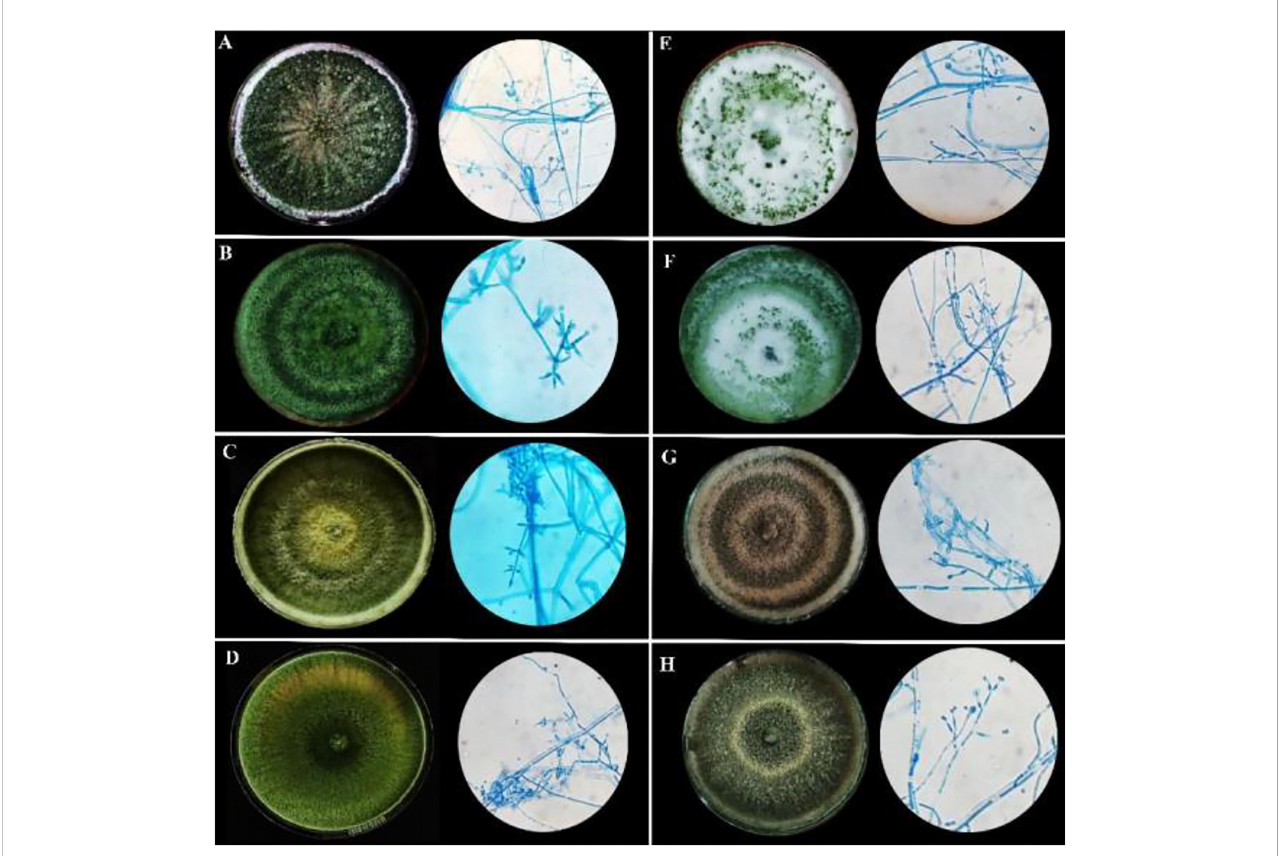
FIGURE 1 Morphological characteristics of rhizospheric fungal colonies on PDA media after sporulation with a detailed study of conidiophore, conidia, and phialides under 40X light microscope. (A) MC2 (B) NBG (C) NBY (D) MCG (E) JC1 (F) JC3 (G) NC1 (H)